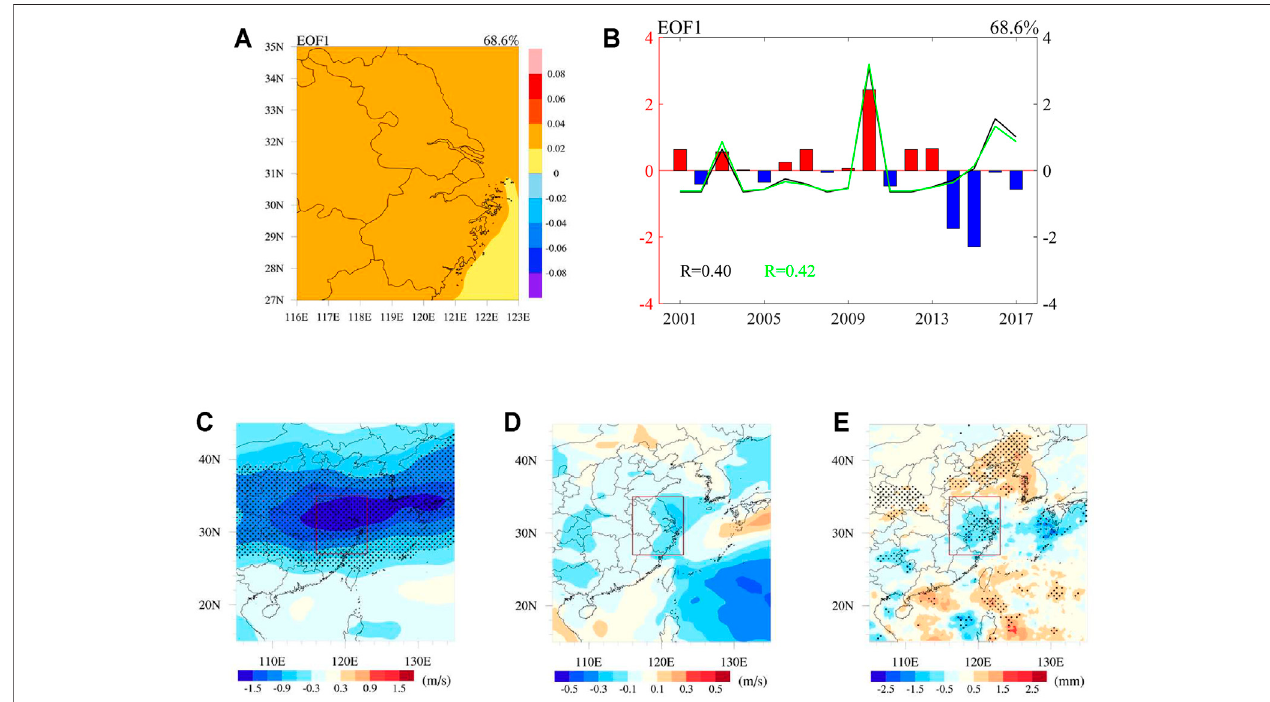
FIGURE 3 | The results for the fi rst EOF (EOF1), including (A) the spatial pattern of EOF1, (B) the time series of EOF1 (histogram), the South China Sea subtropical high area index (black solid line) and the South China Sea subtropical high intensity index (green solid line), and the regression coef fi cients between time series of EOF1 and (C) 500 hPawindspeed, (D) 10 mwindspeed,and (E) precipitation.In (B) ,theindexesarenormalized.In (C) to (E) ,thespottedareapasses90%ofthesigni fi cance test, and the red rectangular region indicates the YRD.